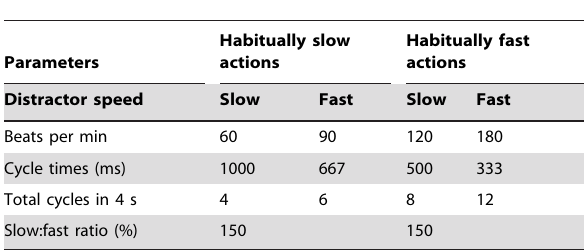
Table 1. Distractor stimuli